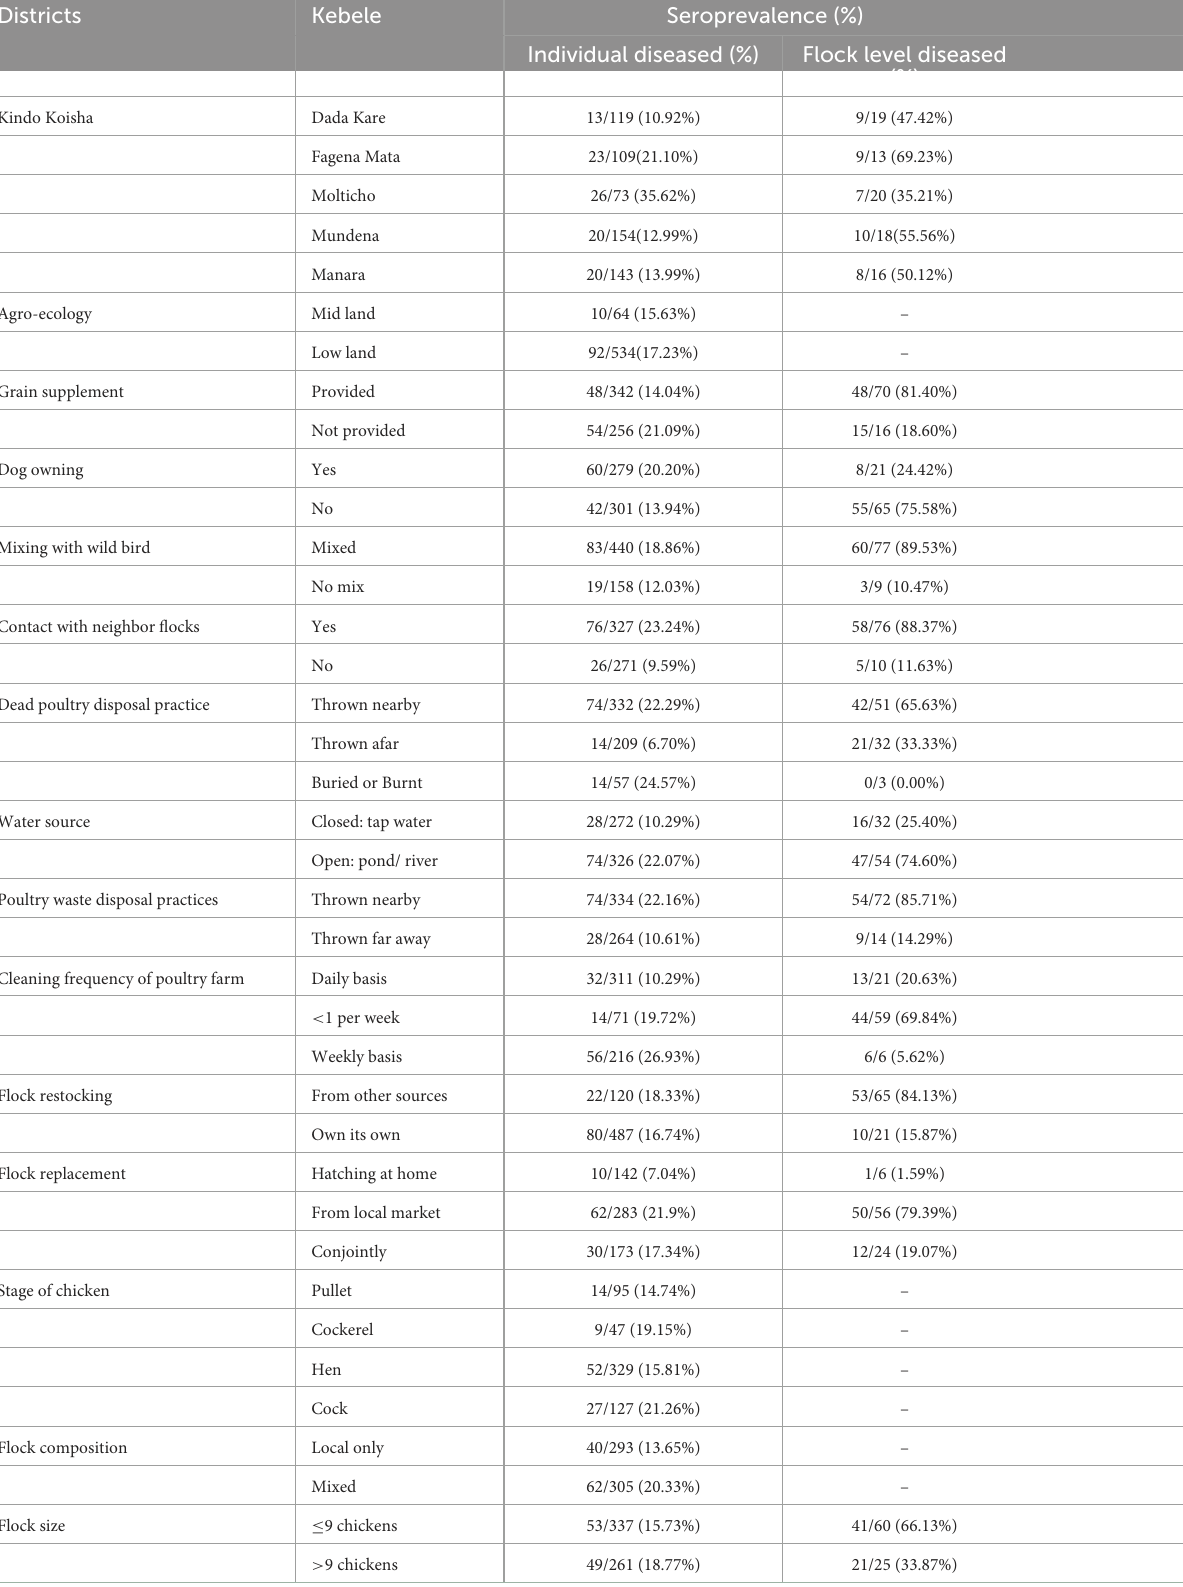
TABLE 2 Newcastle disease seroprevalence at individual and household flock level.